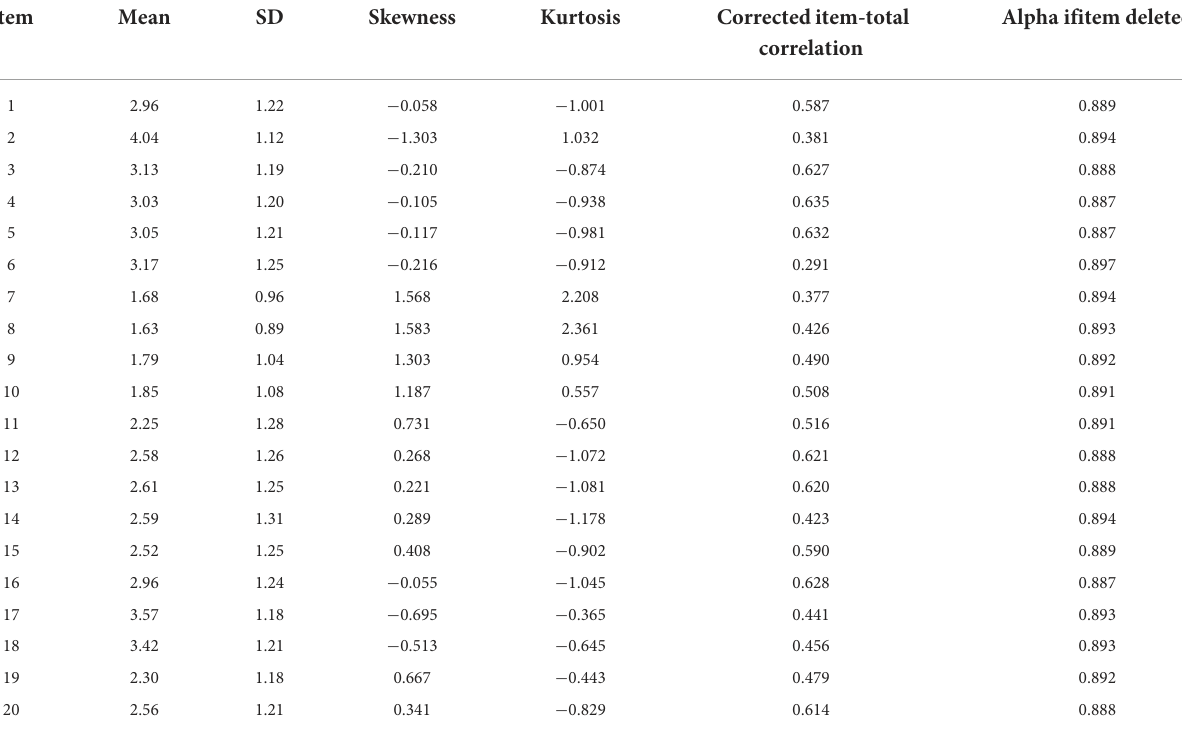
TABLE 1 Descriptive statistics of the C19P-SC